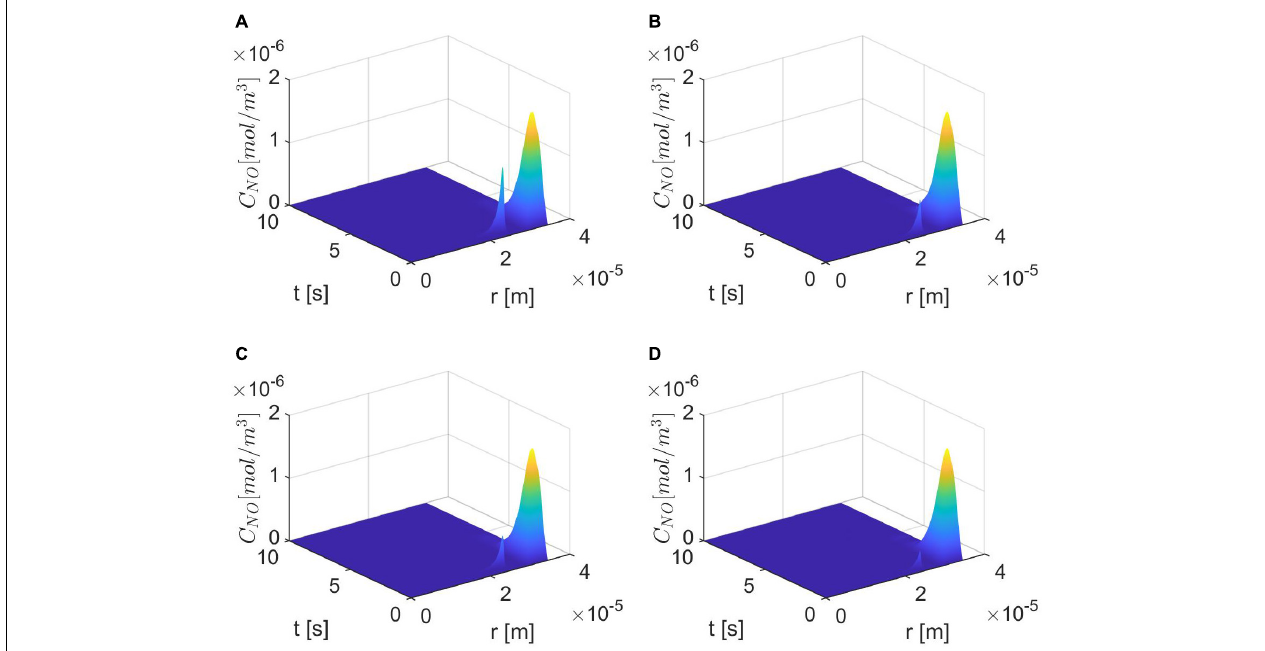
FIGURE 7 | Spatiotemporal variations of C NO for ε = 0 . 85 , p = 0 . 75 ( q = 0 . 25 ), (A) E = 6 × 10 3 N / m , γ = 0 . 75 , ˜ λ = 6 . 5325 × 10 3 s − 1 , (B) E = 6 × 10 4 N / m , γ = 1 . 25 , ˜ λ = 6 . 5325 × 10 3 s − 1 , (C) E = 6 × 10 3 N / m , γ = 0 . 75, ˜ λ = 13 . 065 × 10 3 s − 1 , and (D) E = 6 × 10 4 N / m , γ = 1 . 25, ˜ λ = 13 . 065 × 10 3 s − 1 .